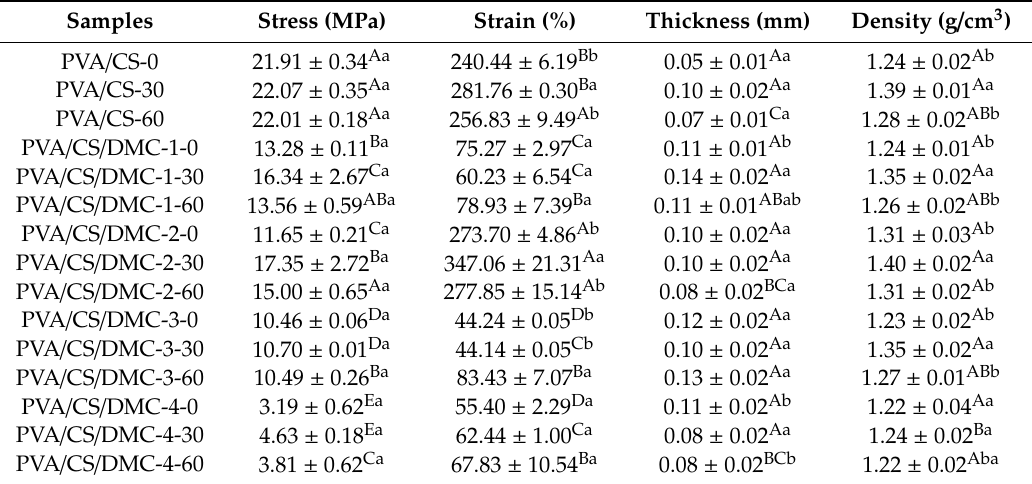
Table 3. Mechanical strength and density properties of di ff erent composite films in the case of varying ultrasonication